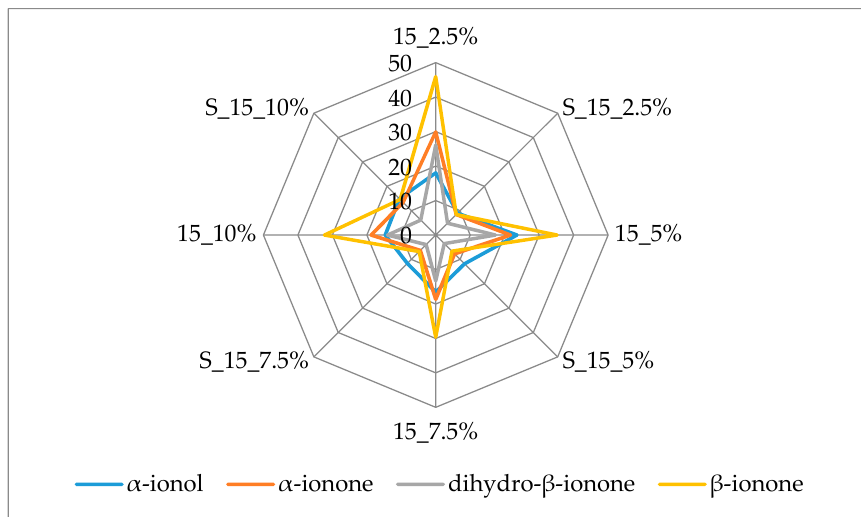
Figure 3. Amount of berry volatiles on cellulose/raspberry complexes after 15 min of complexation and after storage (2.5%, 5%, 7.5% and 10%—amounts of used cellulose; 15—time of complexation; S—storage).